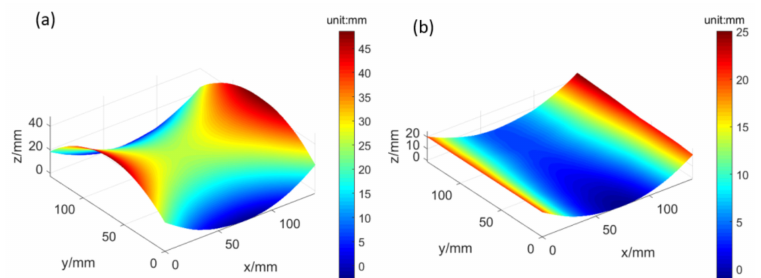
Figure 10. The height maps of the contour of an object with a hyperbolic paraboloid surface obtained using ( a ) the proposed 2D digital shearography with source displacement and ( b ) the traditional 1D digital shearography with source displacement.